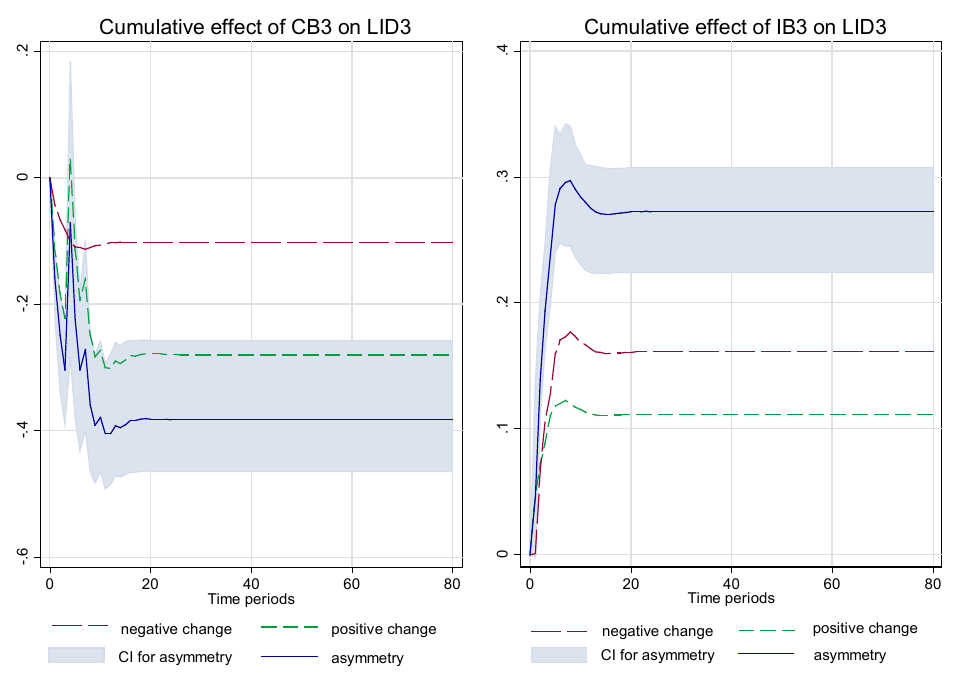
Figure 2. Dynamic multipliers, 3-month